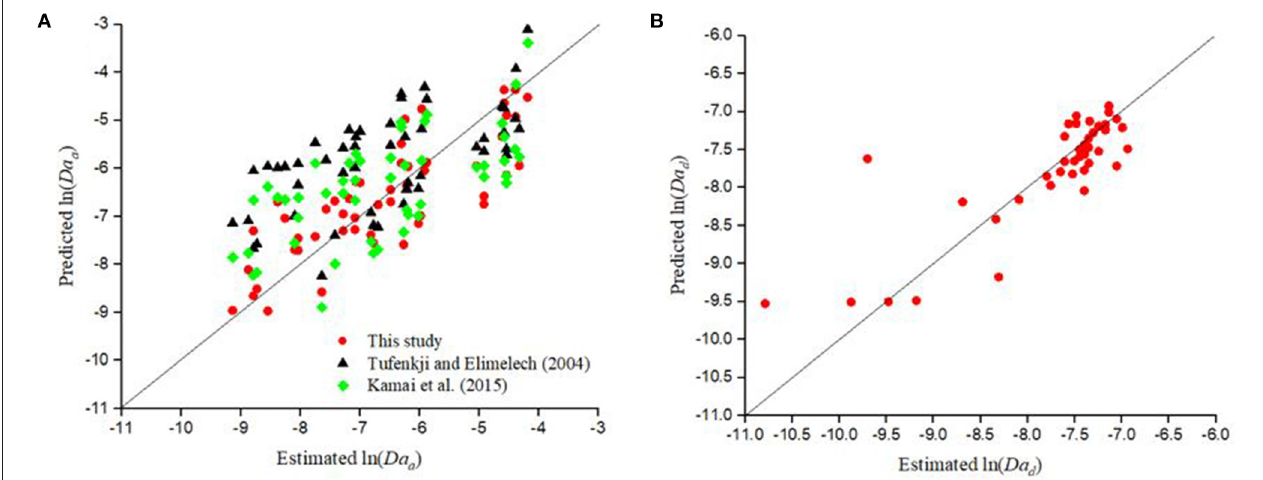
FIGURE 5 | Comparison of values of (A) Da a (red circles, R 2 = 0.69) and (B) Da d (red circles, R 2 = 0.69) values predicted by the empirical equations developed in this study for CML colloids vs the corresponding estimated values reported in the literature ( Supplementary Table 6 ) obtained by fitting column experimental data with a 1D mathematical model. Also shown in (A) are the values of Da a predicted by CFT with η 0 calculated using the model of Tufenkji and Elimelech (2004; black triangles, R 2 = 0.39) and Kamai et al. (2015; green diamonds, R 2 = 0.41) with the value of α calculated using the empirical equation developed by Bai and Tien